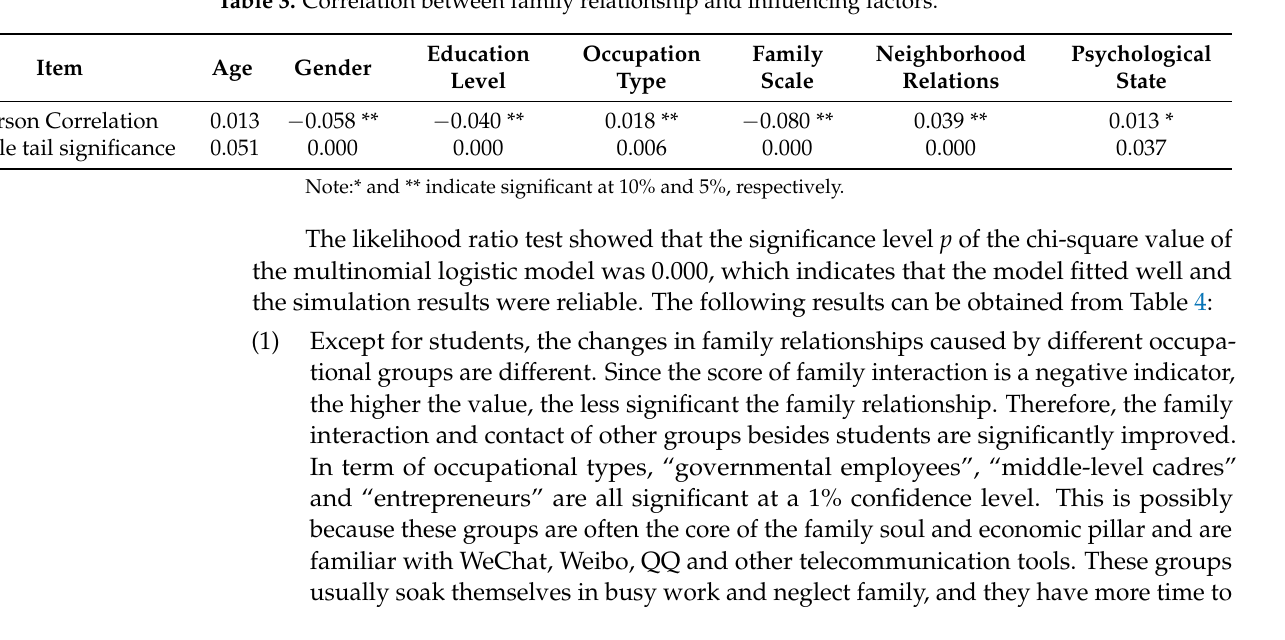
Figure 6. The interaction of family members in different settlements.